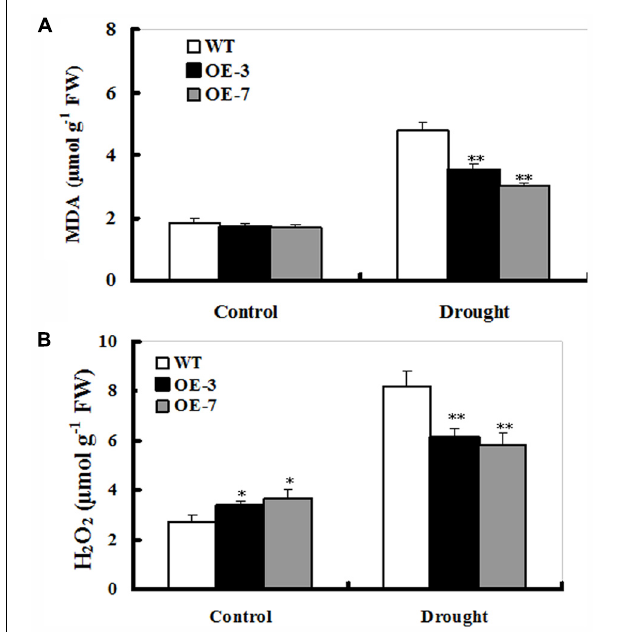
FIGURE 4 | Changes of MDA and H 2 O 2 in ZmSO -overexpressing tobacco lines under drought stress. (A) Determination of MDA accumulation in leaves of WT and both OE lines (OE-3 and OE-7) after 9-day drought stress. (B) Quantitative determination of H 2 O 2 accumulation in leaves of WT and both OE lines (OE-3 and OE-7) after 9-day drought stress. In both (A,B) , each experiment was repeated three times. Bar indicates SE. ∗∗ t -test, with P < 0.01; ∗ t -test, with P <